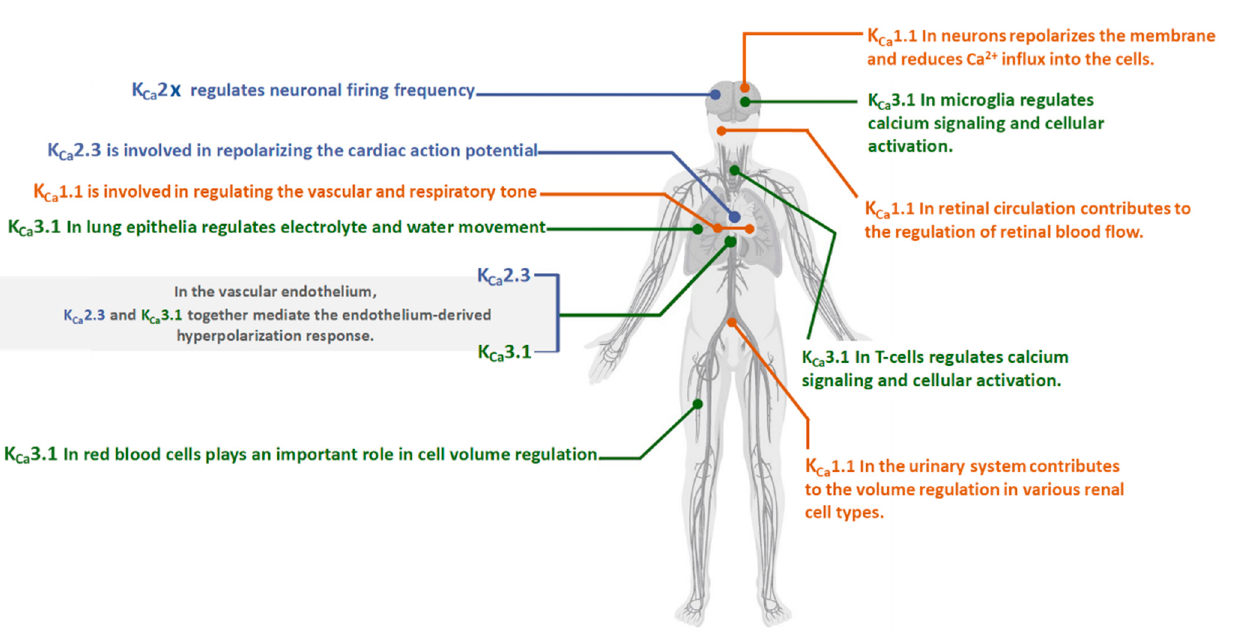
Figure 1. Expression and Physiology of the K Ca 2x, K Ca 3.1, and K Ca 1.1 channels